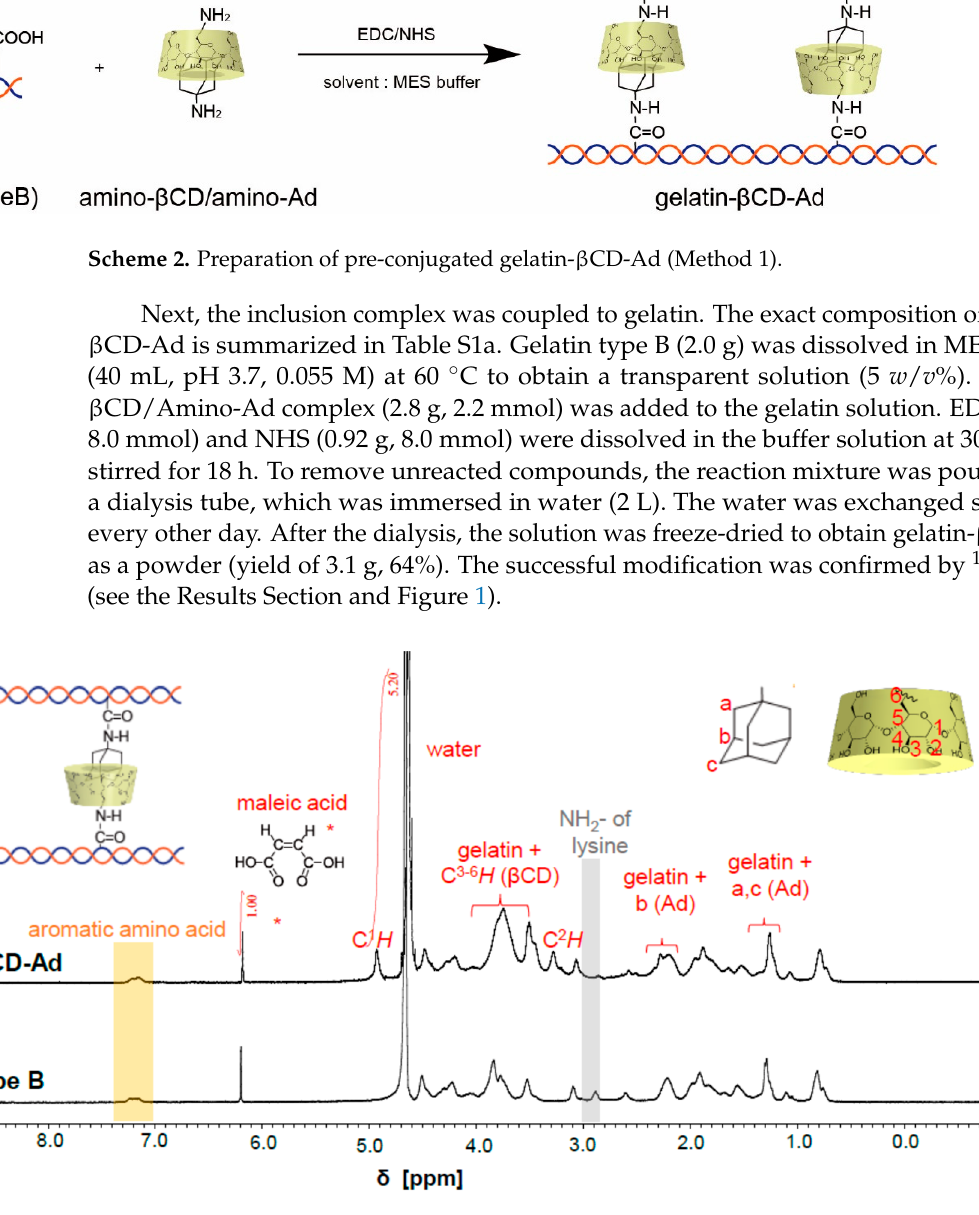
Figure 1. 1 H NMR spectra of ( a ) gelatin modified with host-guest pair and ( b ) unmodified gelatin in D 2 O, acquired on a 500 MHz JEOL ECA-500 NMR spectrometer at 25 °C. Chemical shifts were referenced to maleic acid as the standard ( δ = 6.2 ppm). Insets show positions of protons in chemical structures corresponding to the peaks in 1 H NMR spectra: 1-6 for CD unit, a-c for Ad unit, and * for maleic acid.